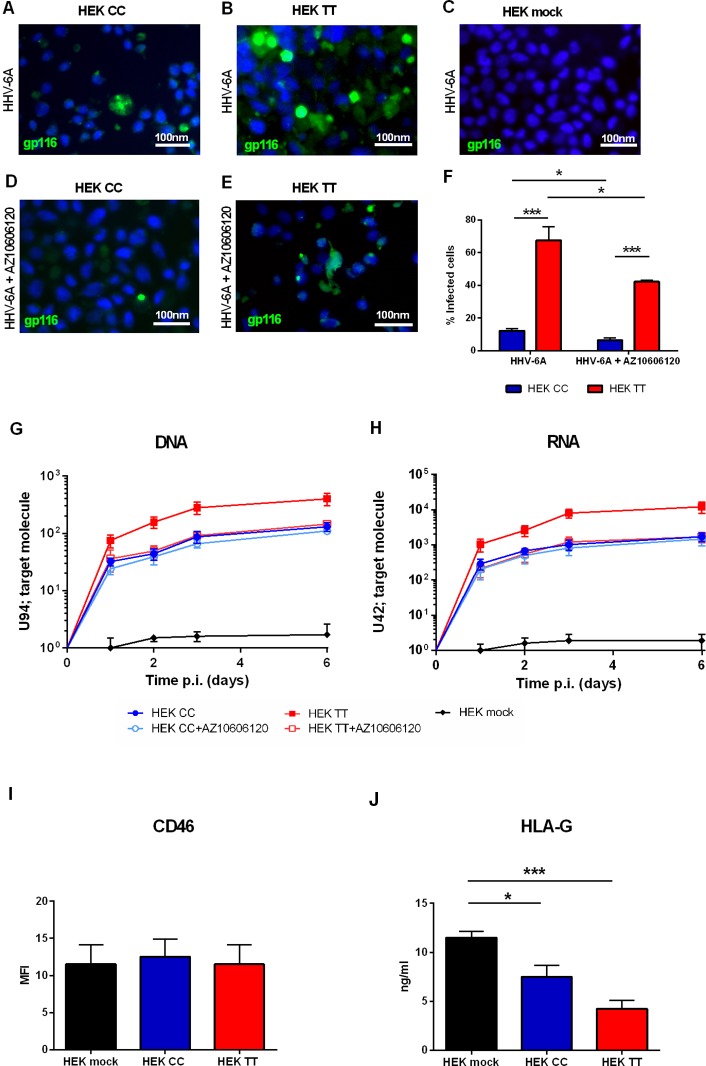

(A–H) HHV6-A infection of HEK293 cells. Cells were infected with 100 genome equivalents per cell of HHV-6A for 2 h at 37°C in the presence or not of P2X7R antagonist AZ10606120 (2 µM). (A–E) Fluorescence pictures of HHV-6A infected HEK CC (A, D), HEK TT (B, E), and HEK mock cells (C) stained with anti-gp116 mAb. (F) Percentage of HEK CC and HEK TT cells positive for HHV-6A gp116 protein in the presence or not of P2X7R antagonist AZ10606120. HHV-6A positivity significantly differs among groups [p < 0.0001, analysis of variance (ANOVA) test]. Data for each group are shown as the mean ± SEM of four experiments. Groups were compared with each other using two-tailed Student’s t-test, *p < 0.05, ***p < 0.001. HHV6-A U94 DNA (G) and U42 RNA levels (H). U94 DNA and U42 RNA were quantified by polymerase chain reaction (PCR) and quantitative PCR (qPCR) as reported in Materials and Methods. (I) Mean fluorescence intensity (MFI) of HHV-6A membrane receptor CD46 on HEK mock, HEK CC, and HEK TT cells. Expression of CD46 is not significantly different among groups (p = 0.34, ANOVA test). (J) Human leukocyte antigen G (HLA-G) concentration was evaluated in HEK mock, HEK CC, and HEK TT cell culture supernatants and differed among the samples (p = 0.0012; ANOVA test). Data for each group are shown as the mean ± SEM of four experiments. Groups were further compared with each other using two-tailed Student’s t-test, *p < 0.05, ***p < 0.001.